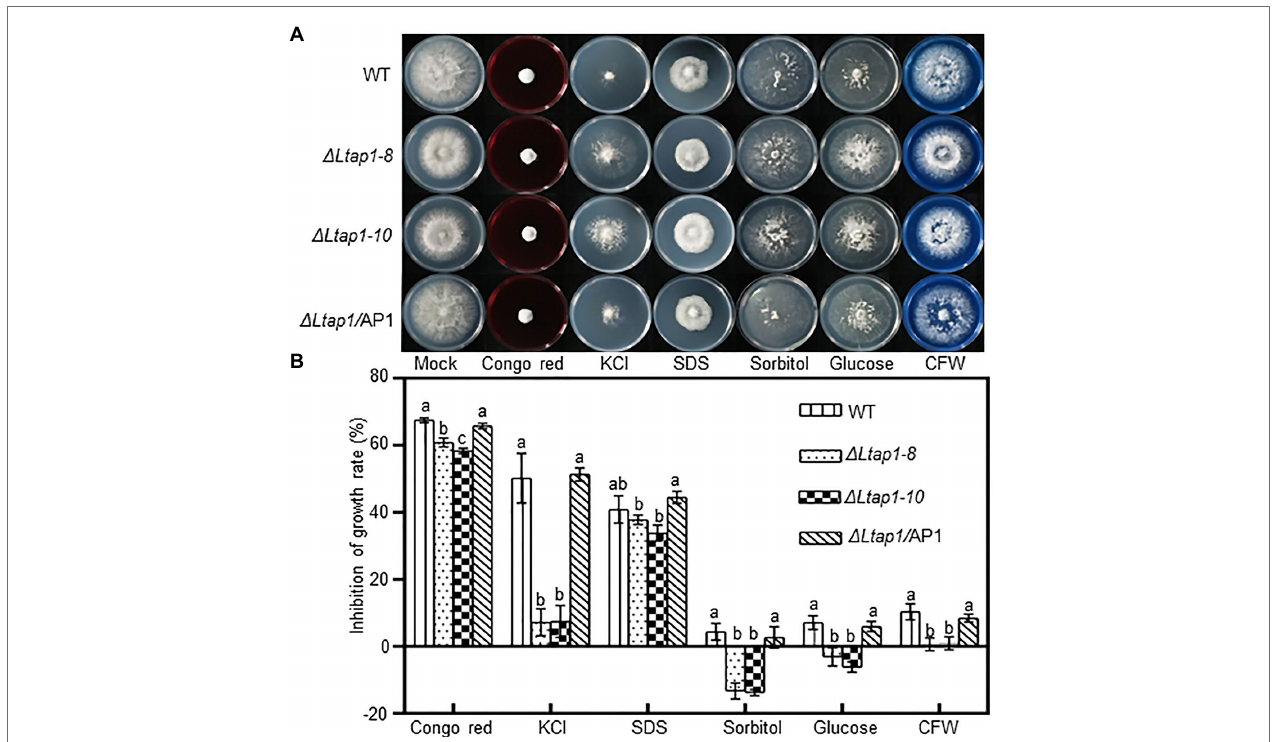
FIGURE 2 | Mycelial growth of the L. theobromae WT and mutants in response to stress treatments. (A) Cultures of the WT, two Δ Ltap1 deletion mutants and the Δ Ltap1/ AP1 strain, grown on PDA media supplemented with 2.5 mg ml − 1 Congo red, 1 M KCl, 0.02% SDS, 1 M sorbitol, 1 M glucose, and 0.05 mg ml − 1 calcofluor white (CFW) or water (mock) at indicated concentrations after 36 h. (B) Percent growth inhibition of WT and mutants on PDA with the inhibitors. Different letters on top of bars represent a statistically significant differences at p < 0.05. Bars show mean inhibition of growth rate averaged across three biological replicates, and error bars represent standard